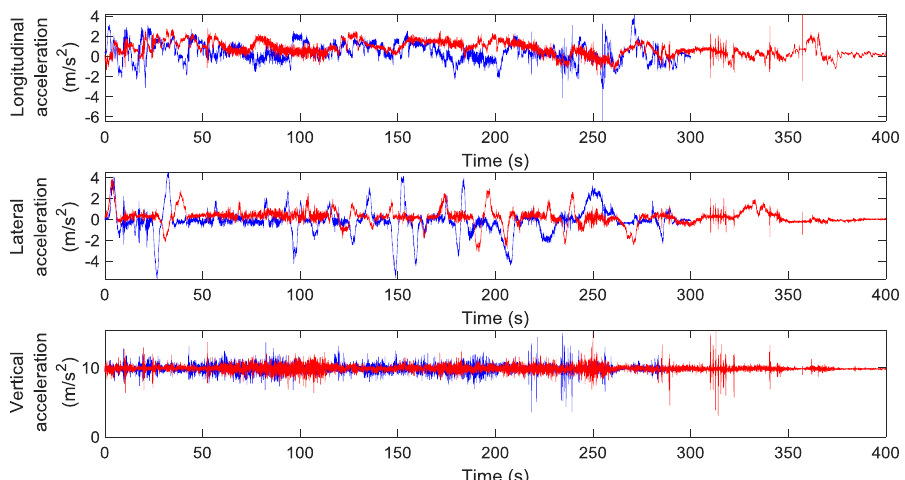
Figure 4. Longitudinal, lateral and vertical acceleration for the same car driven by two drivers to complete the Section 2, one driver (blue) being more aggressive than the other one (red).